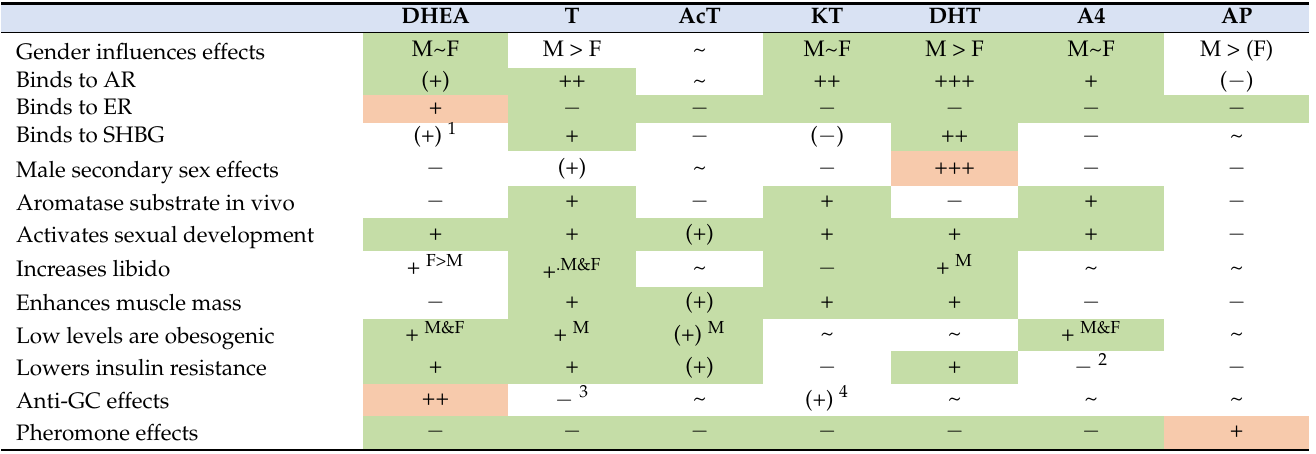
Table 1. Comparison of the physiologic and metabolic effects elicited by the main groups of andro- gens. DHEA T AcT KT DHT A4